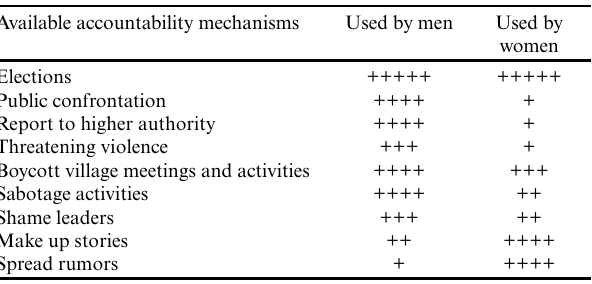
Table 4 . Gendered forms of accountability mechanisms used in Buya 1